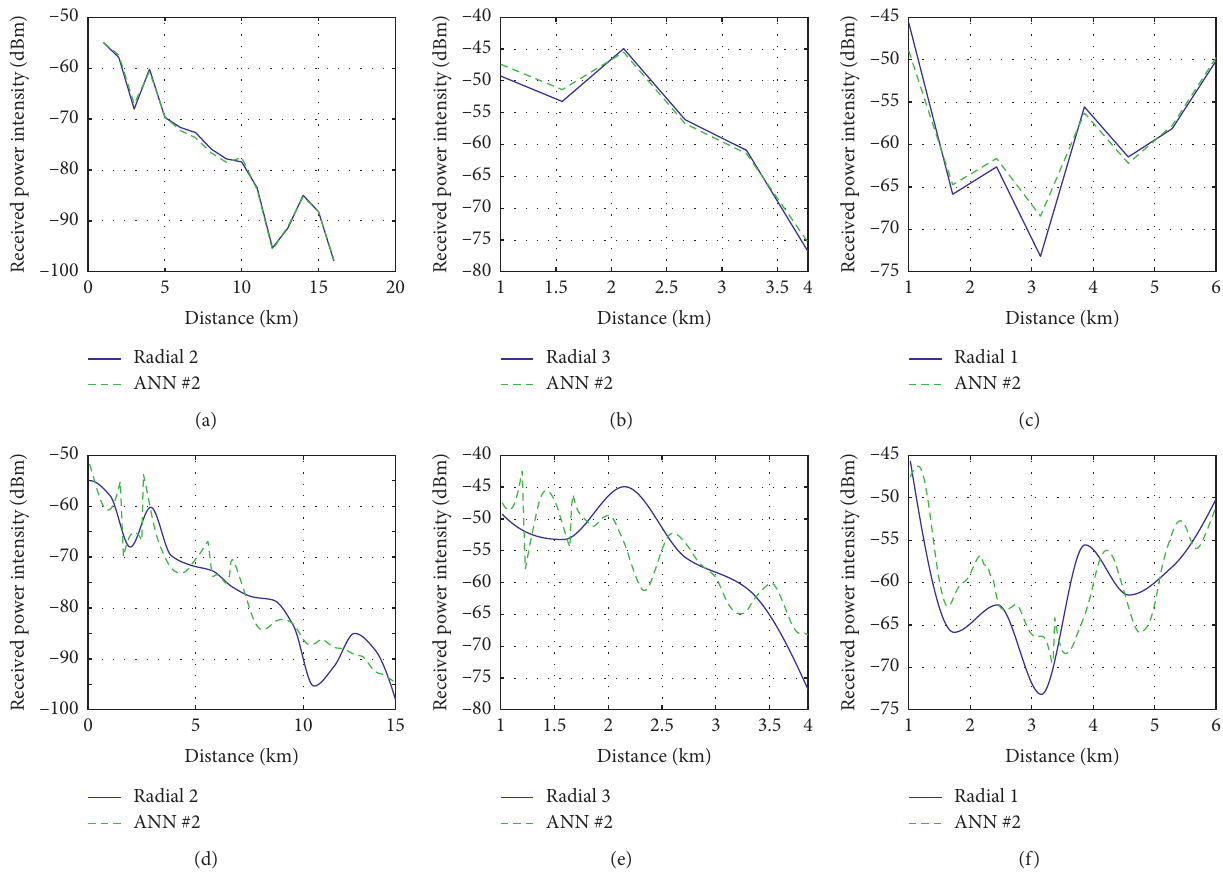
Figure 9: Sum combination for original radial 2 (a); original radial 3 (b); original radial 1 (c); interpolated radial 2 (d); interpolated radial 3 (e);and interpolated radial 1 (f).